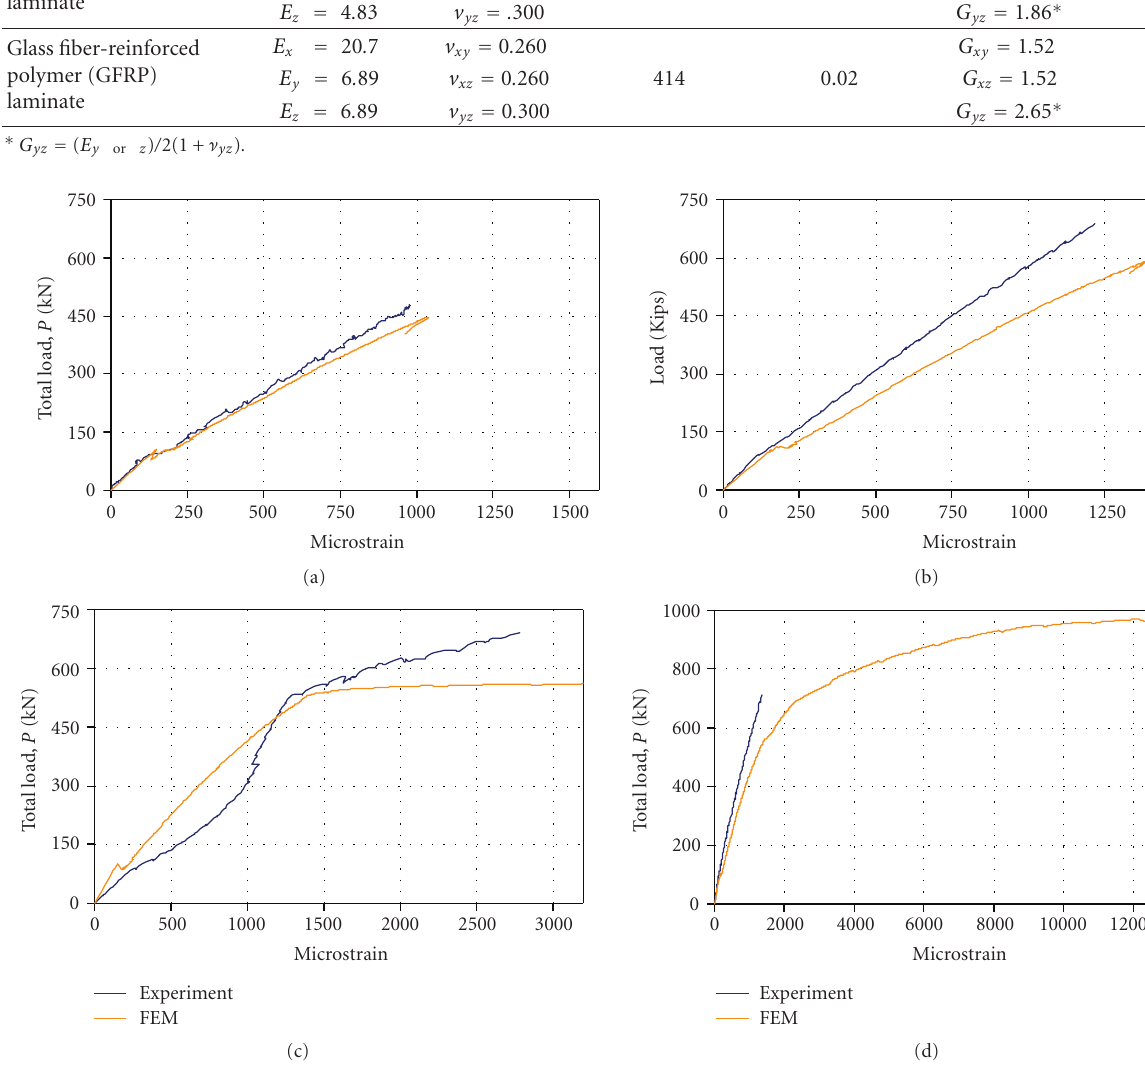
Figure 6: Load-compressive strain plots for concrete. (a) Unstrengthened beam; (b) flexural-strengthened beam; (c) shear-strengthened beam; (d) flexural plus shear-strengthened beam (experimental beam did not